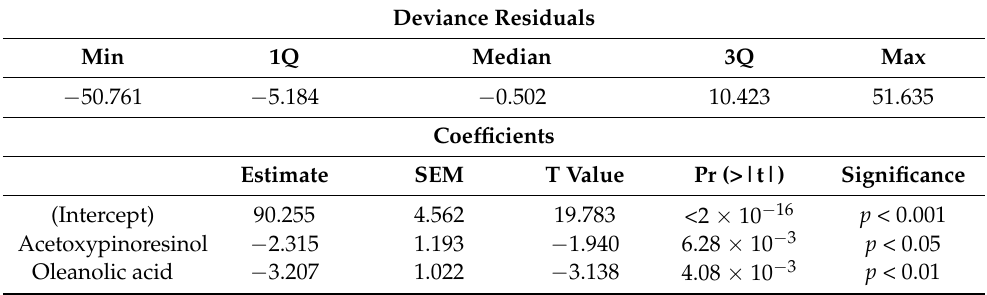
Table 5. GLM 4 summary (antiproliferative capacity,